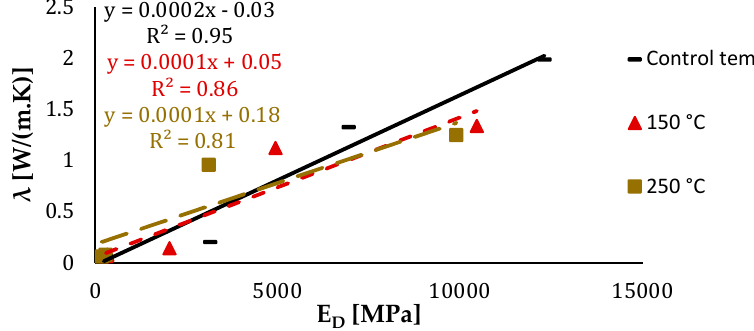
Figure 15. Relationship between Young’s modulus and thermal conductivity.